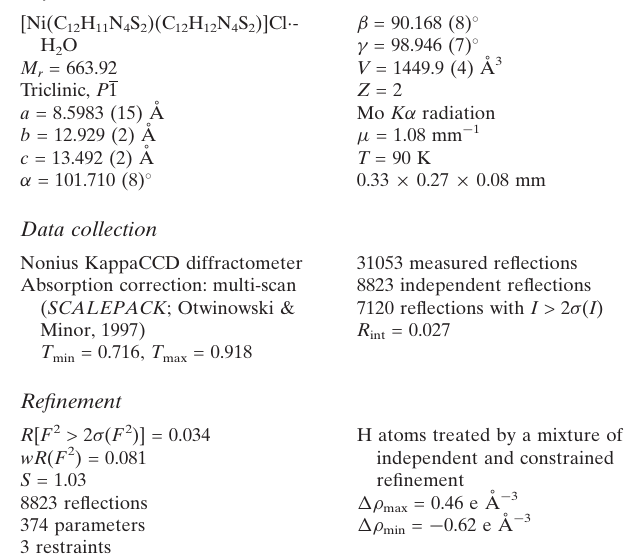
Key indicators: single-crystal X-ray study; T = 90 K; mean (cid:2) (C–C) = 0.003 A˚; disorder in solvent or counterion; R factor = 0.034; wR factor = 0.081; data-to-parameter ratio = 23.6.